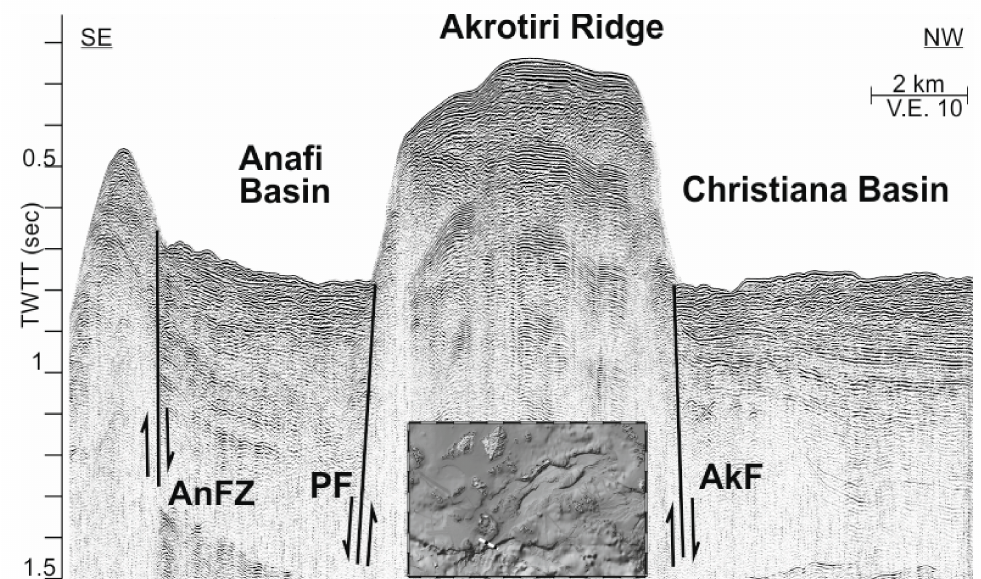
Figure 8. Airgun 40 ci seismic profile crossing the southwestern part of Anafi Basin, Akrotiri Ridge and the southeastern margin of Christiana Basin. AnFZ: Anafi Fault Zone, AkF: Akrotiri Fault, PF: Perissa